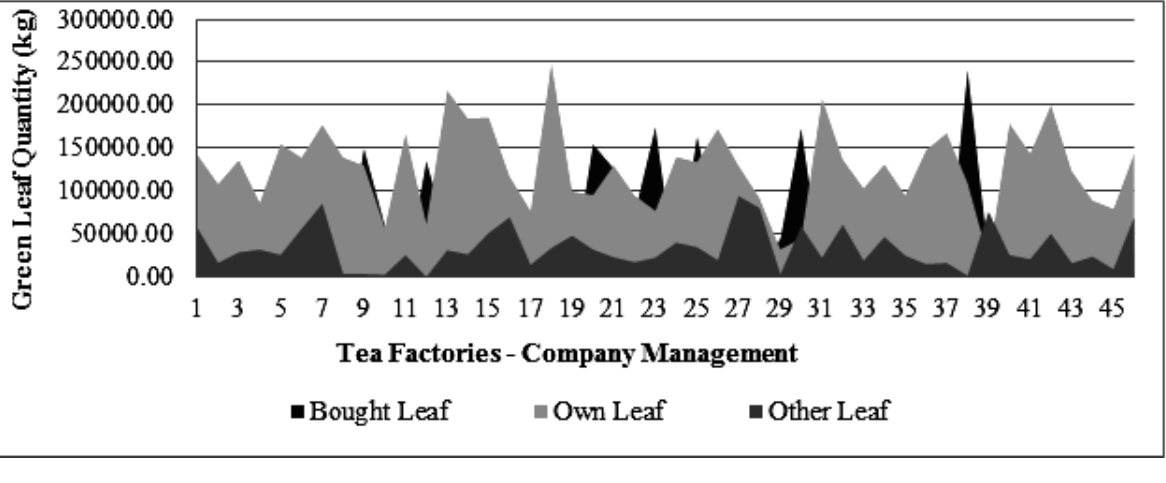
Fig 5: Leaf Supply in Tea Factories under the Company